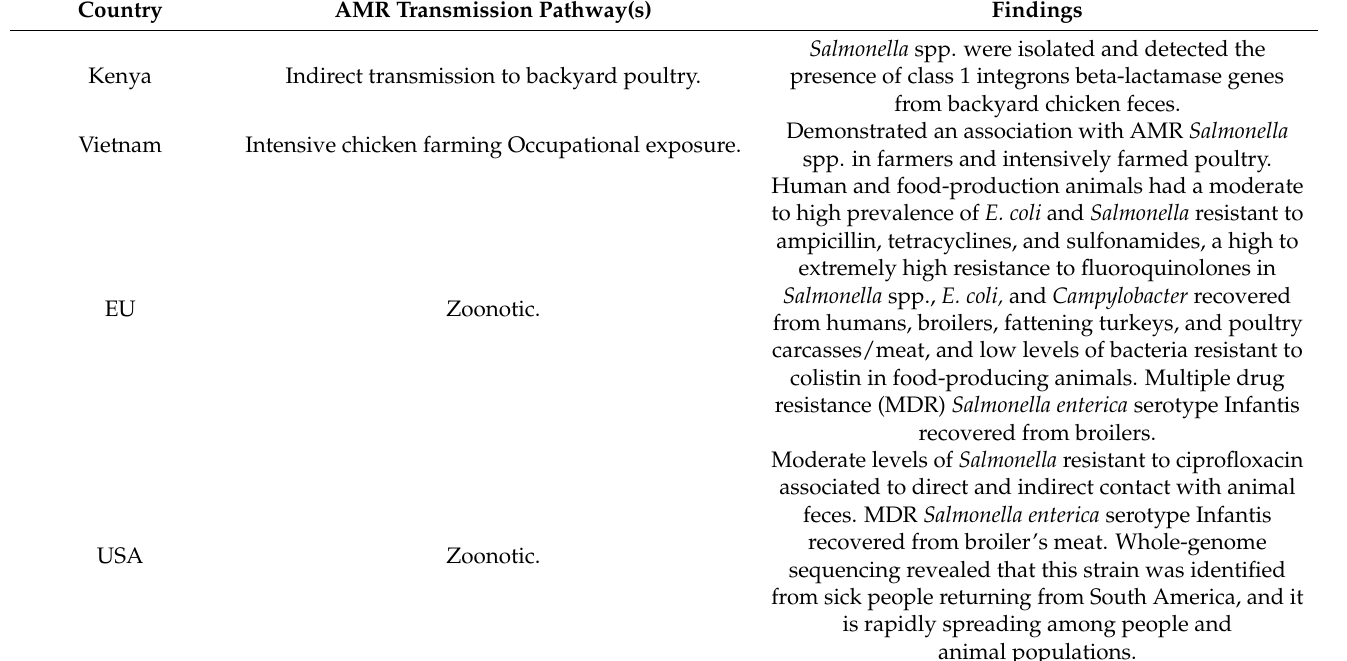
Table 1. Overview of antimicrobial resistance (AMR) of Salmonella transmission pathways originating from poultry production (based on [2]). Country AMR Transmission Pathway(s) Findings Salmonella spp. were isolated and detected the Kenya Indirect transmission to backyard poultry. presence of class 1 integrons beta-lactamase genes from backyard chicken feces. Intensive chicken farming Occupational